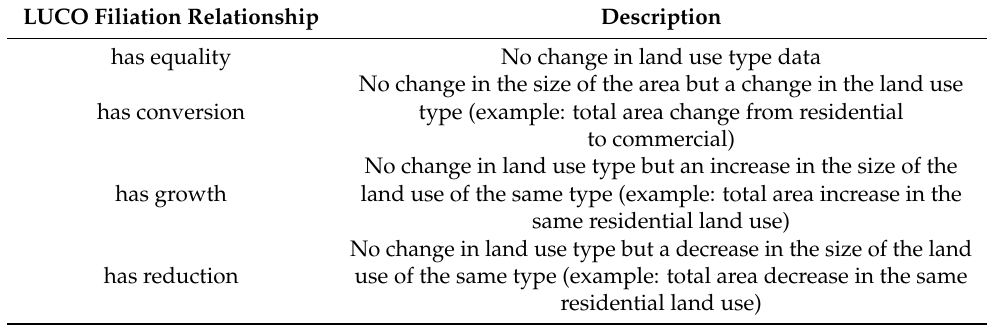
Table 2. LUCO filiation relationship